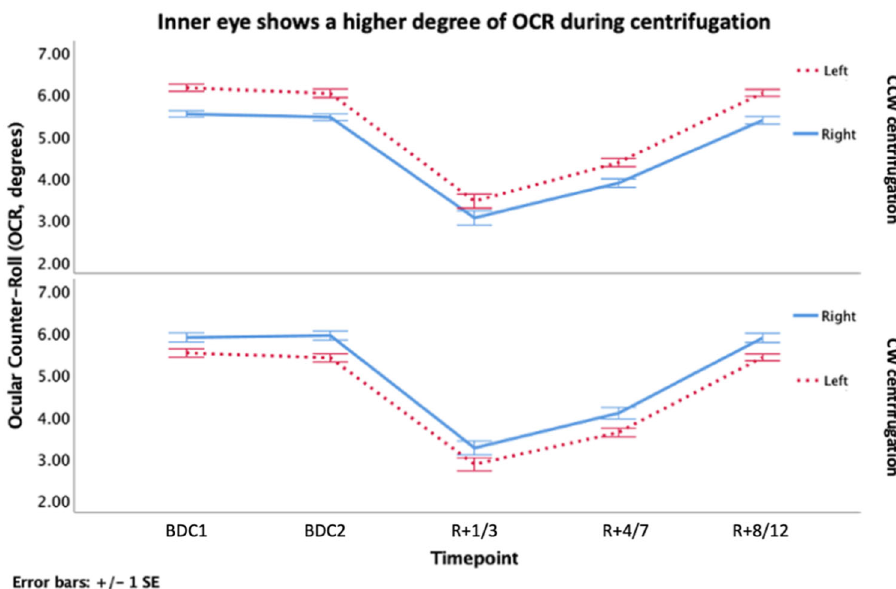
Fig. 5 The inner eye shows a higher degree of OCR during centrifugation. During counterclockwise (CCW) centrifugation, the left eye is de fi ned as the inner since it is the closest to the axis of rotation. This graph shows that the left, inner, eye shows a higher degree of torsion during CCW centrifugation. During clockwise (CW) centrifugation, the right, inner, eye shows a higher degree of OCR compared to the left, outer, eye. Baseline data collection (BDC, pre fl ight), return after X days ( R + X, post fl ight), CCW, and CW. Error bars represent standard error of mean with multiplier